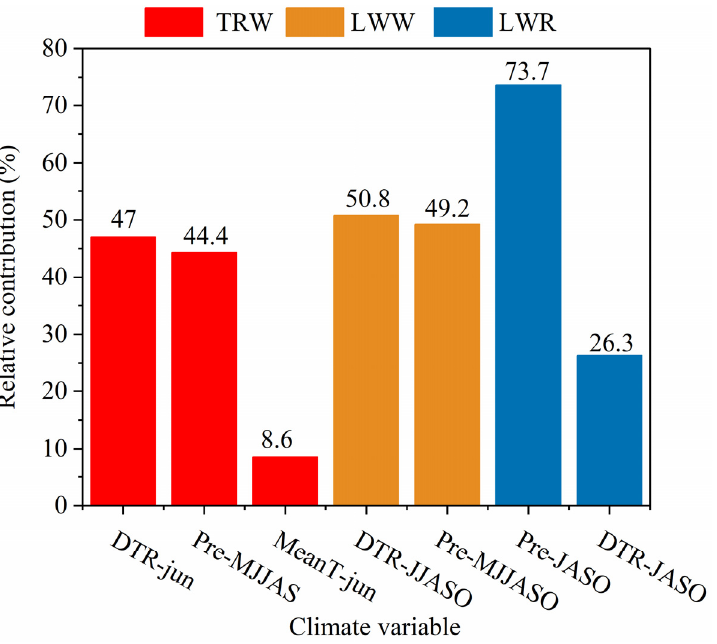
Figure 10. The relative contribution of most significant climate factors to variations in the TRW and LWW and LWR in the BRT model. DTR, Pre and MeanT indicate the diurnal temperature range, precipitation and mean temperature. jun: current June; MJJAS: the period from current May to September; JJASO: the period from current June to October; MJJASO: the period from current May to October; JASO: the period from current July to October.